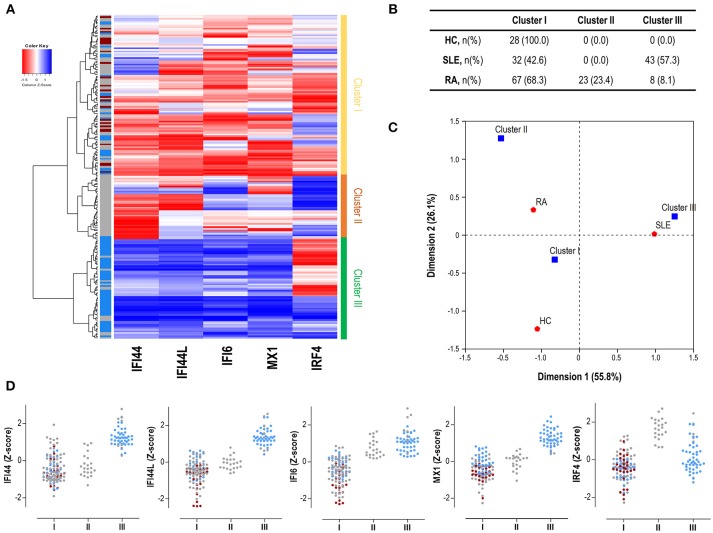
Gene signatures defined by IRF4 and IRGs. (A) Heatmap and cluster analysis revealing the identification of the three clusters based on the expression of IRF4 and IRGs (columns). Each row represents a study subject. Colors in the vertical left bar denoted HC (dark red), SLE patients (blue), or RA patients (gray). Vertical right bar indicates the clusters identified: cluster I (yellow), cluster II (orange), and cluster III (green). Tiles are colored based on gene expression levels, red and blue indicating low or high levels, respectively, as indicated in the legend (top left). (B) Table indicating the number of individuals of each study group (HC, SLE patients, and RA patients) using the different clusters identified. (C) Correspondence analysis (weighted chi-square distances) to study the associations between disease status (red signs) and the three clusters identified (blue signs). Axes represent the dimensions derived from the analysis. (D) Levels of expression for all the genes analyzed (IRF4 and IRGs) stratified by the clusters identified in the analysis. For each cluster, dots are colored according to disease status as follows: HC (dark red), SLE patients (blue), and RA patients (gray). Each dot represents one individual. These graphs were only included for visualization purposes since they were derived from previously identified expression profiles, based on individual gene expression levels. Then, no statistical analysis was performed.